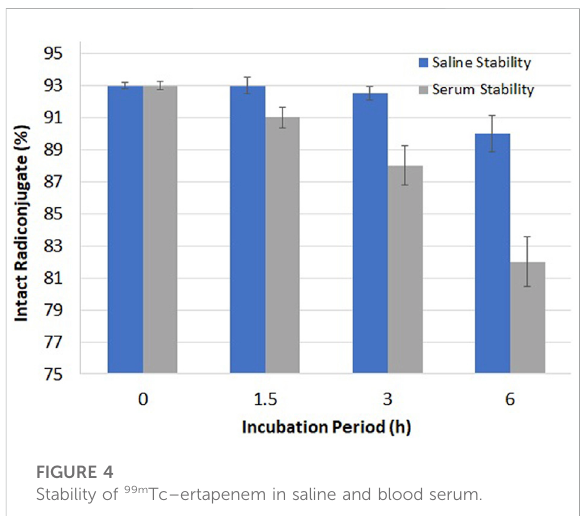
FIGURE 4 Stability of 99m Tc – ertapenem in saline and blood